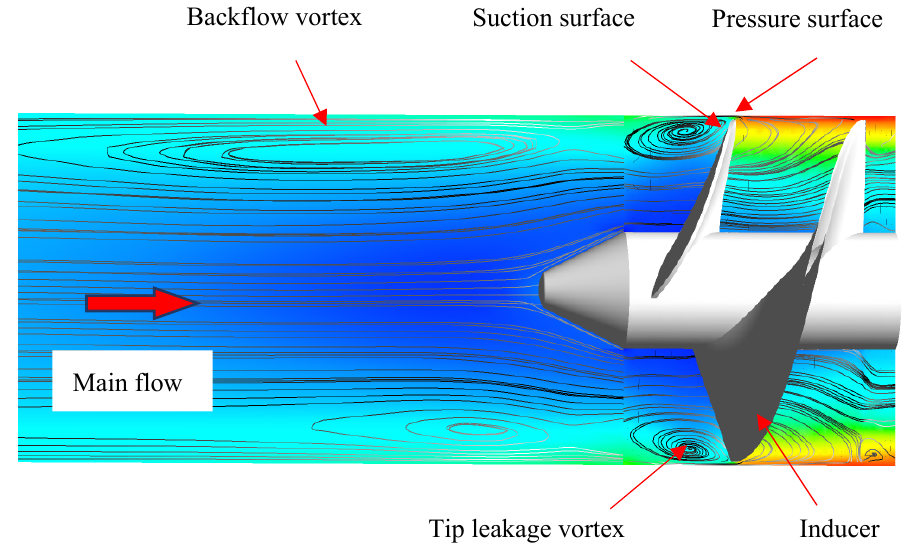
Figure 6. Streamline diagram in the inducer under Q = 0.3 Q d .